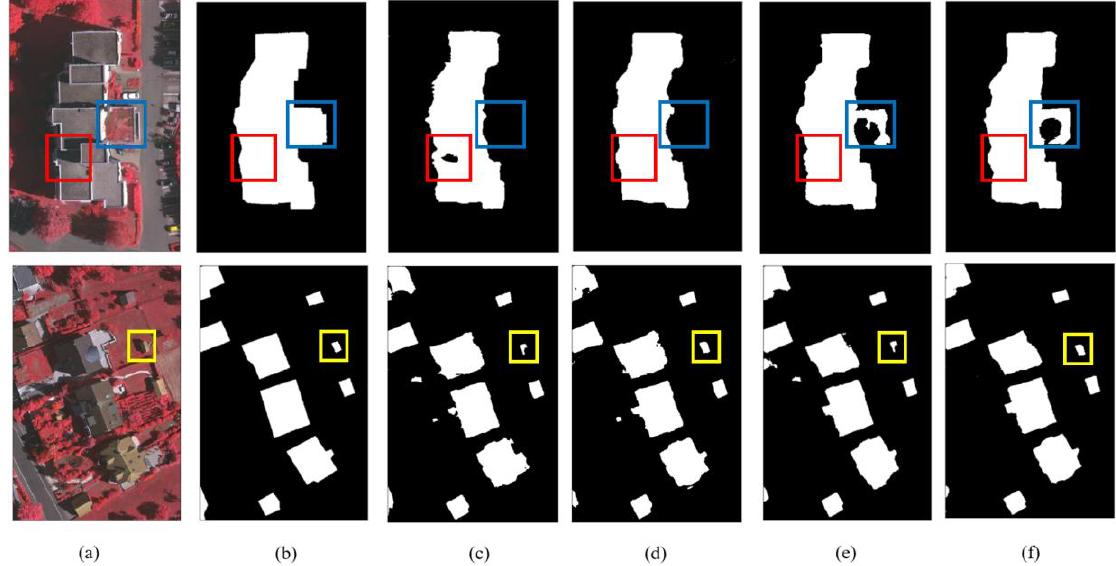
Figure4. The building extraction maps of Images from Vaihingen data. (a) Original image. (b) Ground truth. Extracted building map from (c) UNet11. (d) UNet11 with SE block. (e) UNet16. (f) UNet16with SE